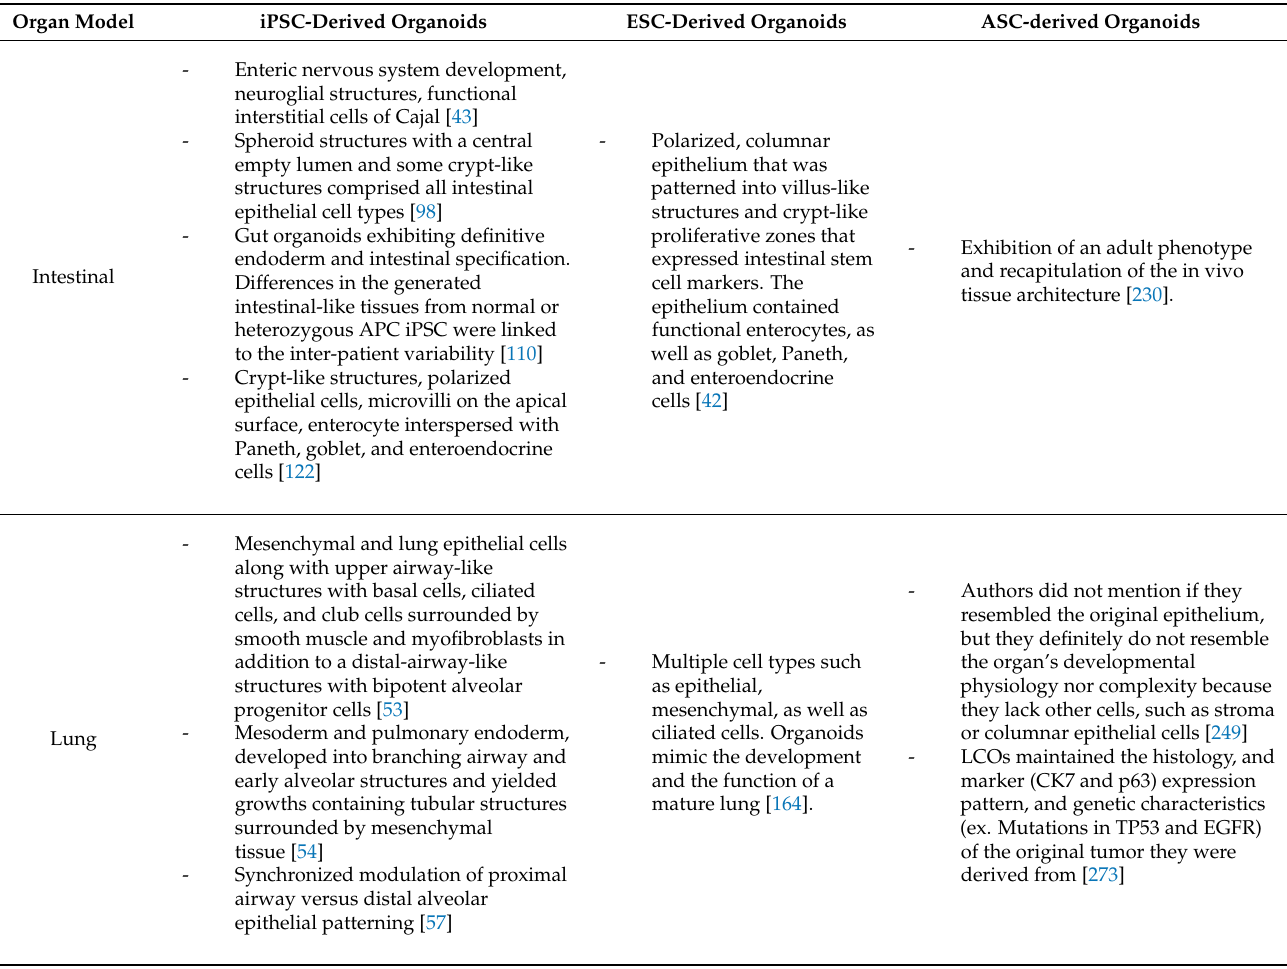
Table 2. Differences in the recapitulation of the native organ’s physiology based on the source of